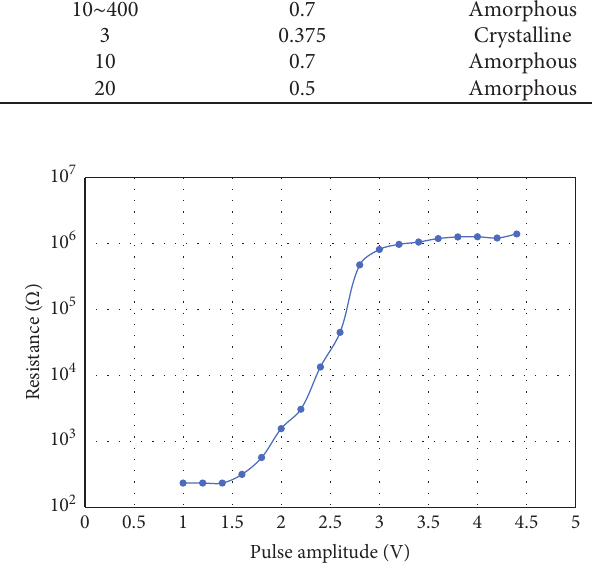
Figure 6: Pulse amplitude vs. resistance curve of simulation